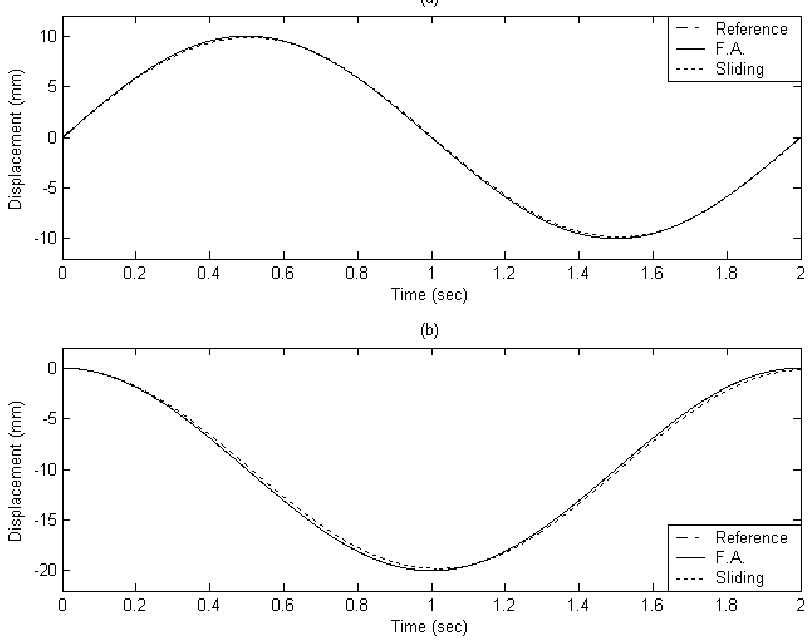
Figure 6. The displacements of (a) X axis and (b) Y axis (case A).